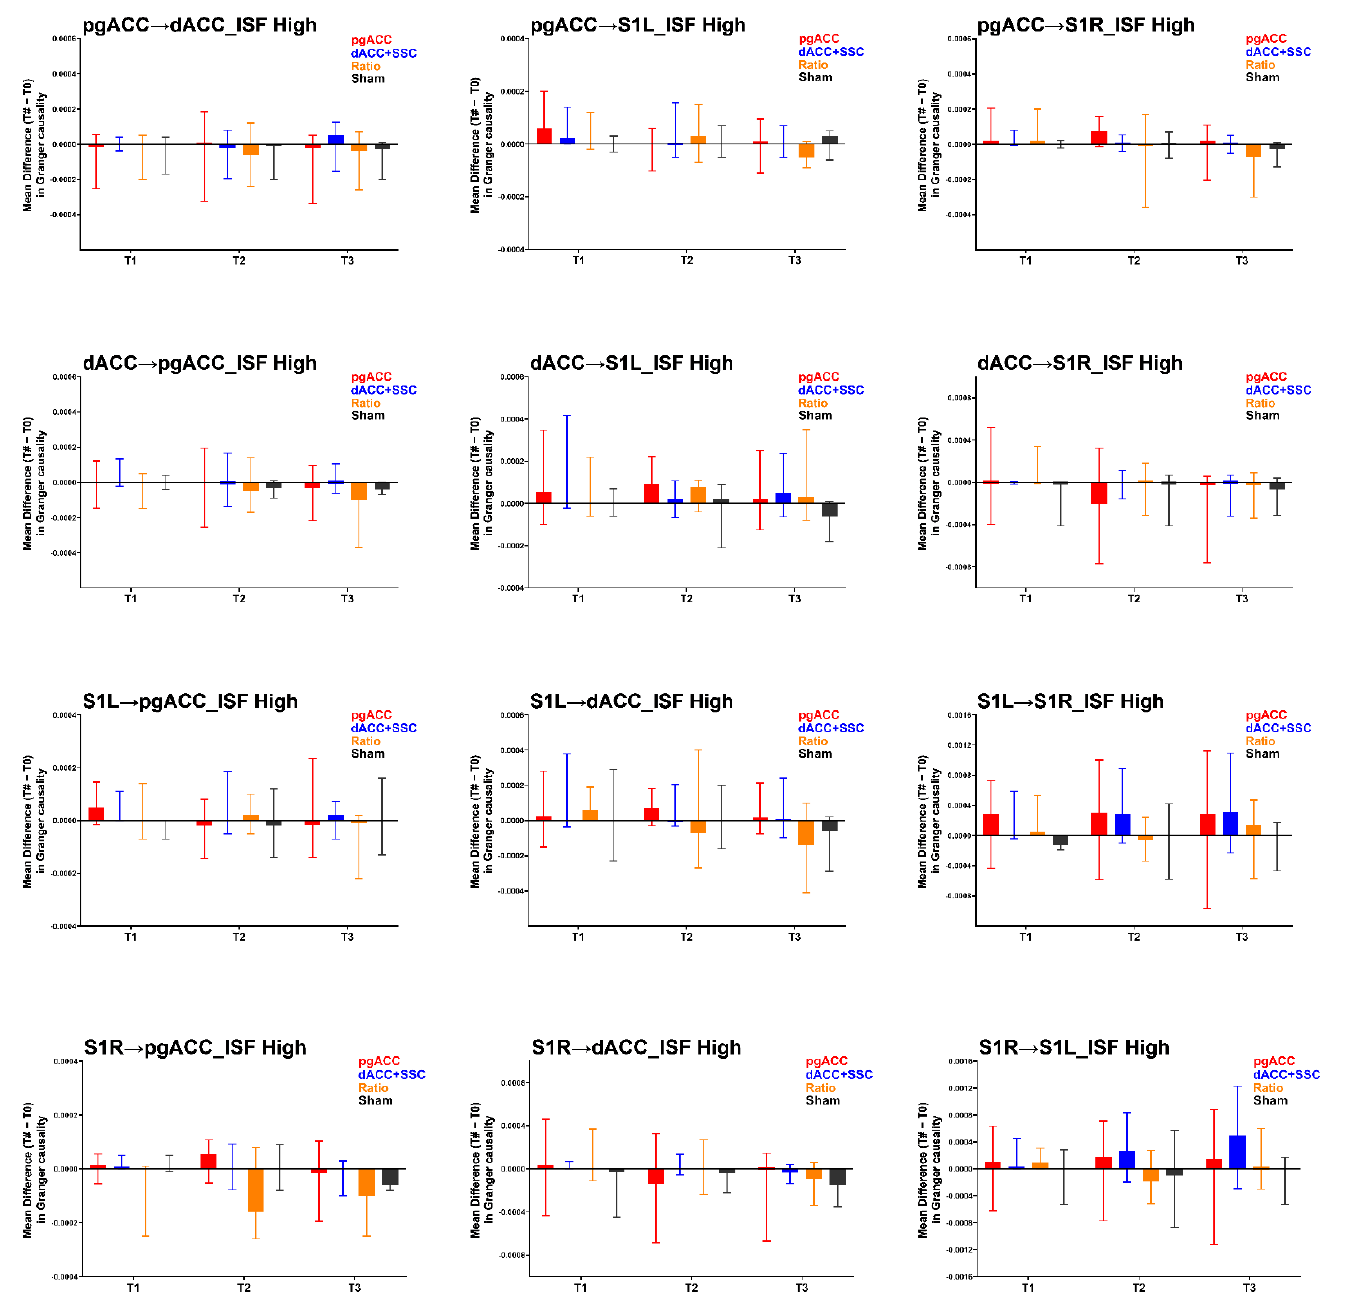
Figure 4. Results of the effective connectivity analysis for the ISF3 band (high: 0.08–0.1 Hz). pgACC: pregenual anterior cingulate cortex; dACC: dorsal anterior cingulate cortex; S1L: primary somatosensory cortex left; S1R: primary somatosensory cortex right; ISF: Infraslow frequency; T1: changes immediately post‑treatment when compared to baseline (T1–T0); T2: changes at one‑week follow up when compared to baseline (T2–T0); T3: changes at one‑month follow up when compared to baseline (T3–T0); ‑>: effective connectivity in the direction of one region to other. Higher values represent increase in the effective connectivity compared to baseline.